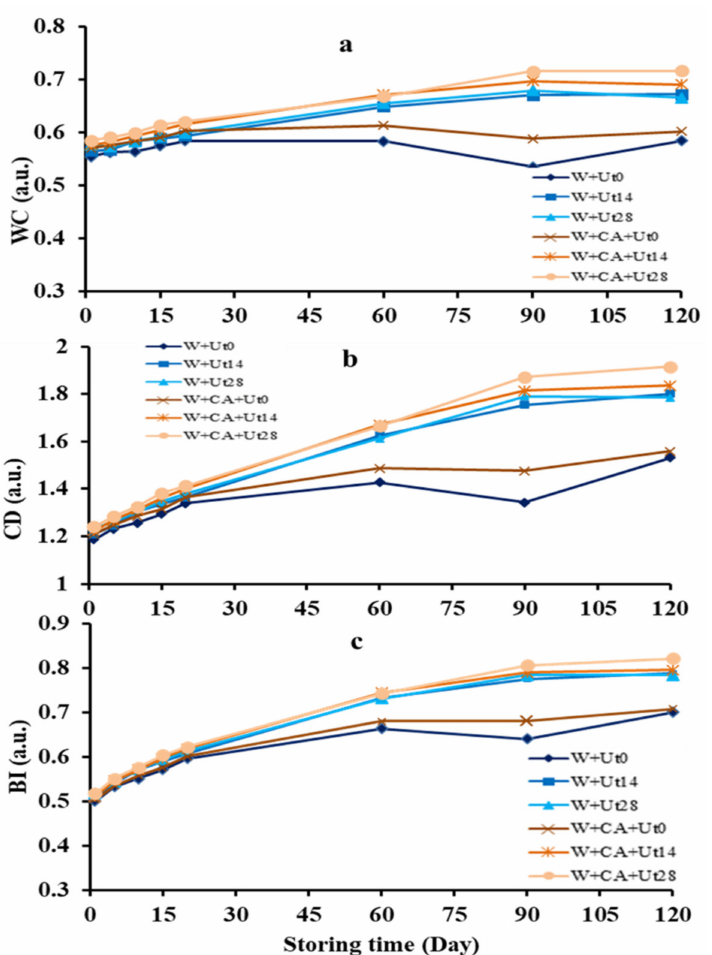
Figure 2. Evolutions of the WC (( a ); wine color), CD (( b ); color density) and BI (( c ); browning index) of red wine samples of W+Ut0, W+Ut14, W+Ut28, W+CA+Ut0, W+CA+Ut14, W+CA+Ut28 during 120 days